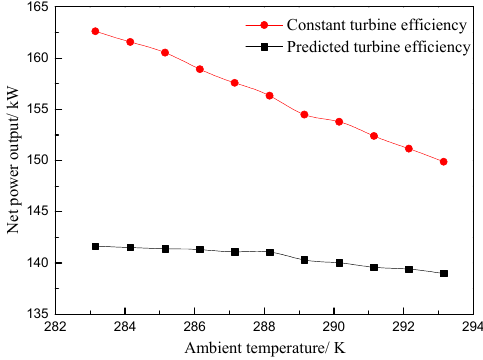
Figure 18. Net power output at different ambient temperature.